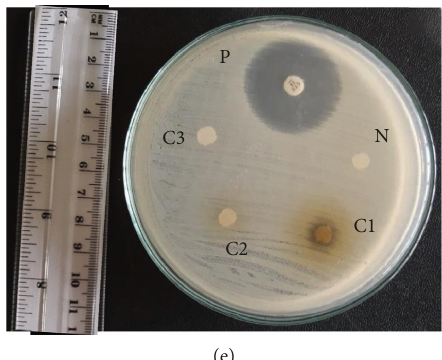
Figure 2: Photographs show only the plants that gave positive results for the disc diffusion assay. (a) Ethanol extract of E. divaricata . (b) Ethanol extract of V. zizanioides . (c) Hexane extract of E. divaricata . (d) Hexane extract of V. zizanioides . (e) Aqueous extract of E. divaricata . P: positive control; N: negative control; C1: crude extract; C2: 10-fold dilution of crude extract; C3: 100-fold dilution of crude extract. Table 4: Concentrations of crude extracts of plants. Medicinal plant